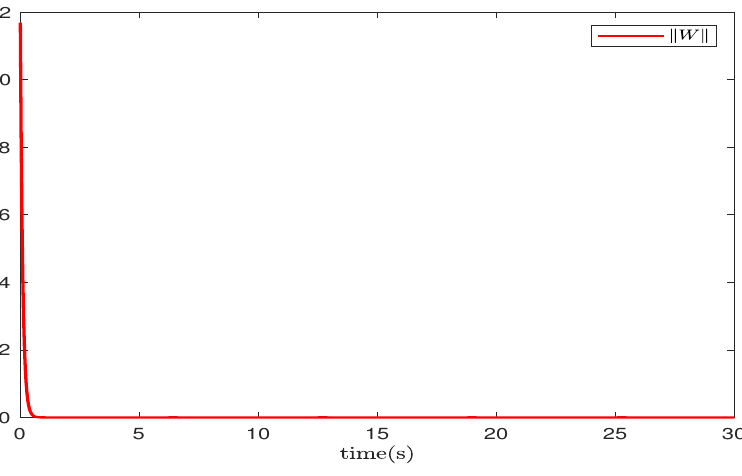
Figure 5. Trajectories of control input u 1 and u 2 .